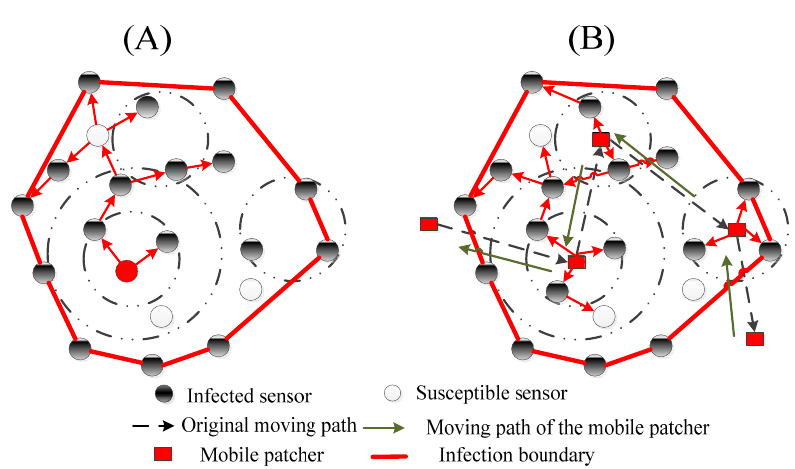
Figure 4. Static patch pattern ( A ) vs. mobile patcher pattern ( B ).